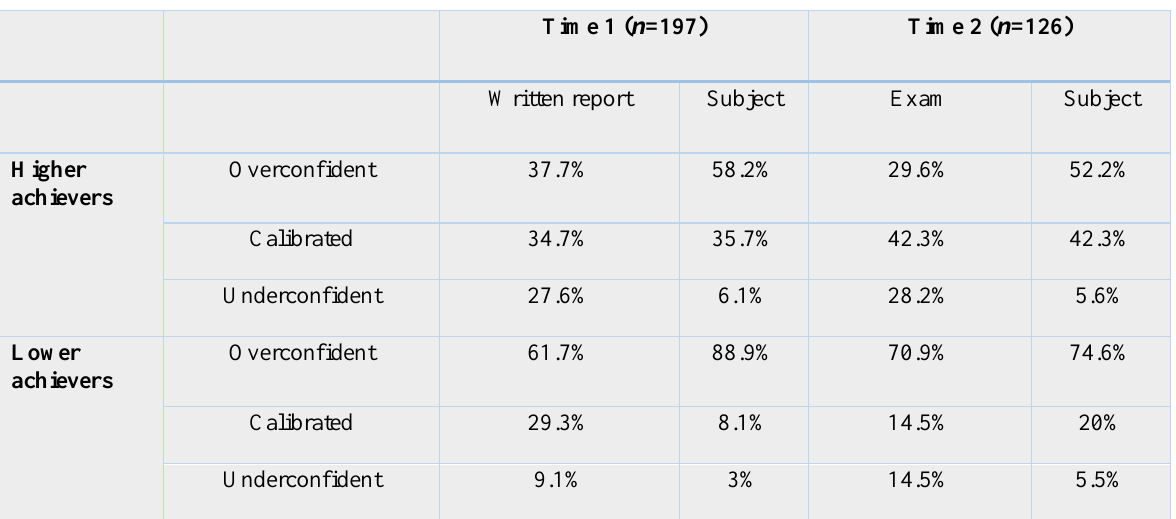
Proportions of overconfident, underconfident and accurately calibrated